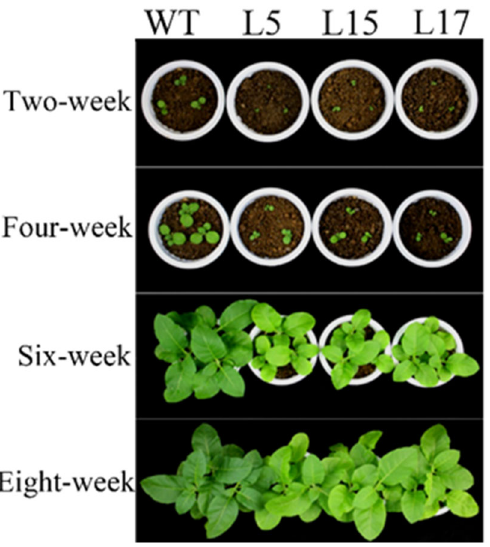
Figure 4. Phenotype of CsCBF2 ‐ overexpressing transgenic tobacco plants after different periods of sowing under normal growth conditions.